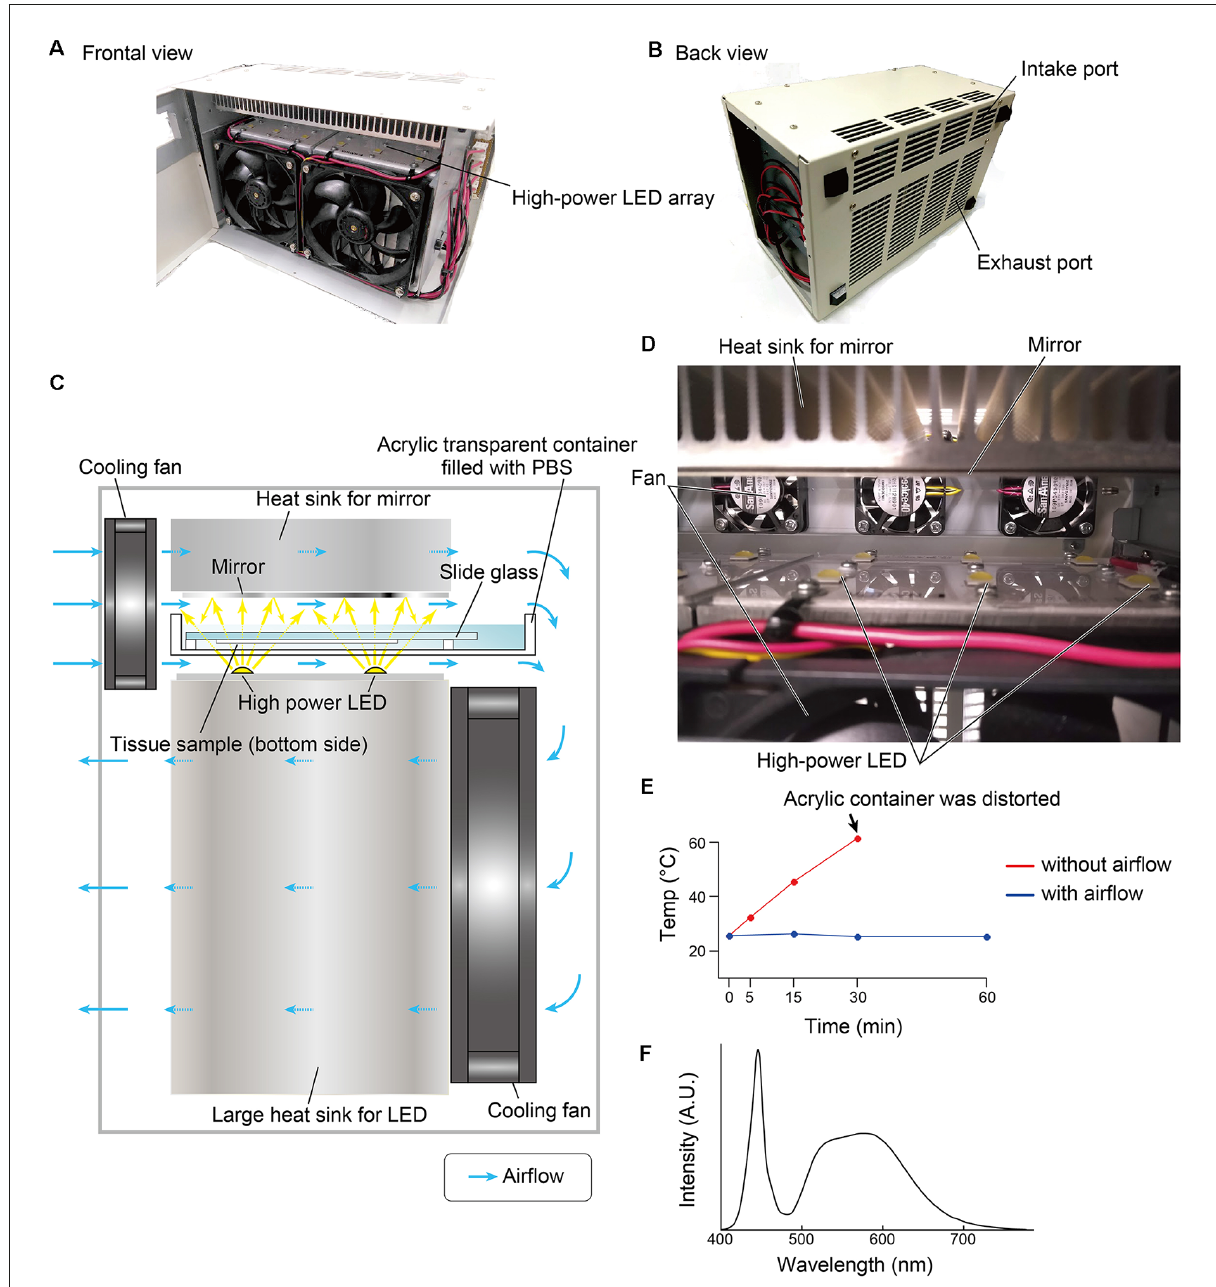
FIGURE1 Overview of the LED illuminator, TiYO TM . (A) Frontal view and (B) back view of the LED illuminator. (C) Lateral illustration of the LED illuminator. Two high-power LEDs (more than 3,000 lumens/single LED) are placed in one column, and the LEDs are arrayed as 2 × 6. LED circuit boards are mounted on a large heat sink (12 × 24 × 12 cm). On the upper side of the sample, a mirror with a heat sink (3 × 24 × 12 cm) is placed. Two heat sinks are cooled by cooling fans. The airflow shown by the blue arrow also removes heat from the buffer solution in the acrylic container. (D) Inside view of the LED illuminator. (E) Temperature change of the buffer solution inside the acrylic container according to the duration of photoirradiation. (F) Spectrum of the LED used in this study.